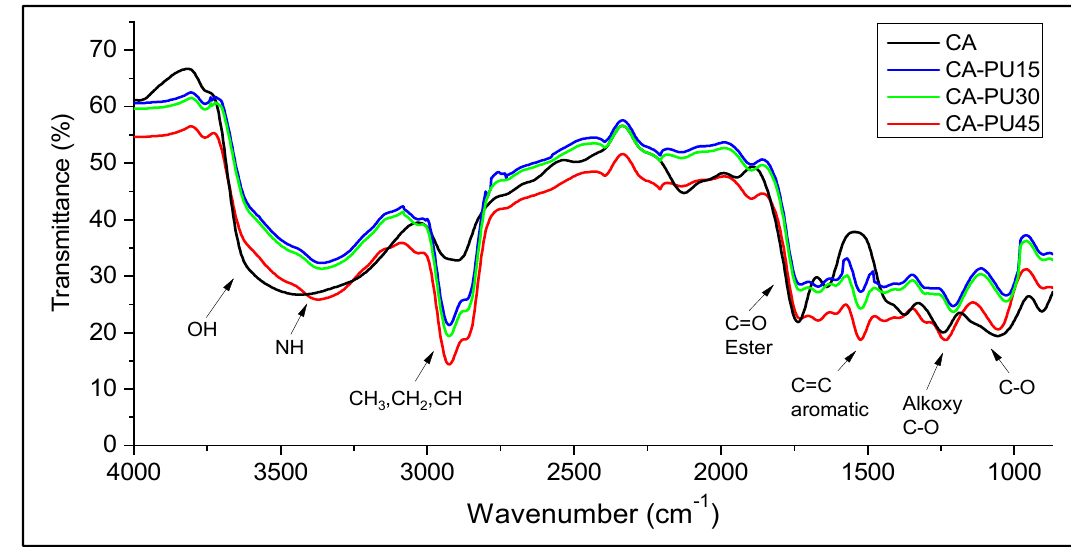
Figure 3. Fourier transform infrared (FTIR) spectra of CA, CA–PU15, CA–PU30, and CA–PU.